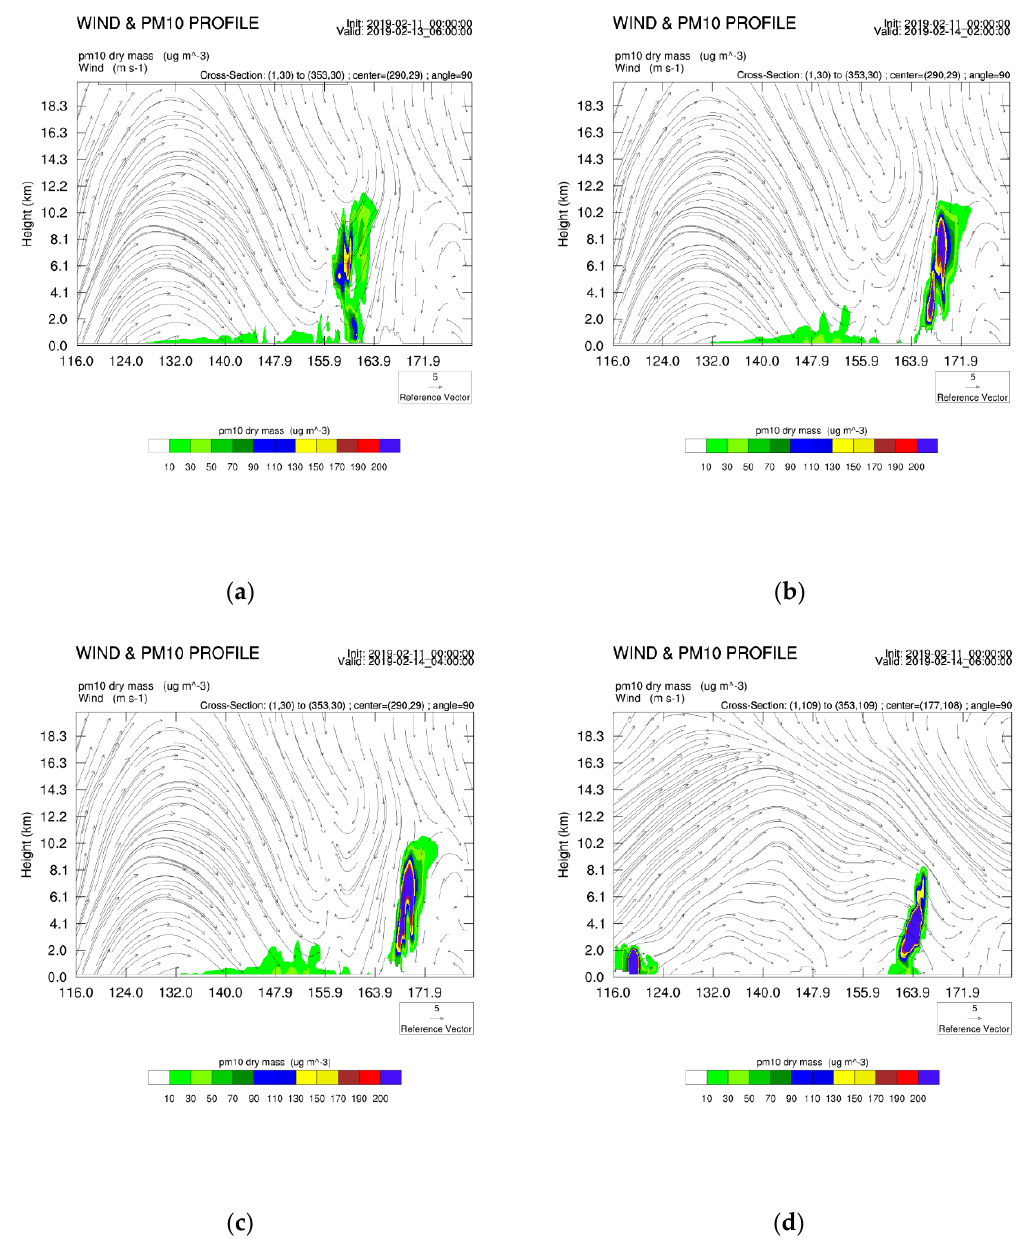
Figure 8. Predicted PM 10 and wind profile along the latitude − 44.10° on 13 February 2019 06:00, 14 February 2018 02:00, 14 February 2019 04:00, and 14 February 2019 06:00 UTC. The vertical topographic outline at the bottom of the graphs shows the Tasman Sea and the South Island of New Zealand.